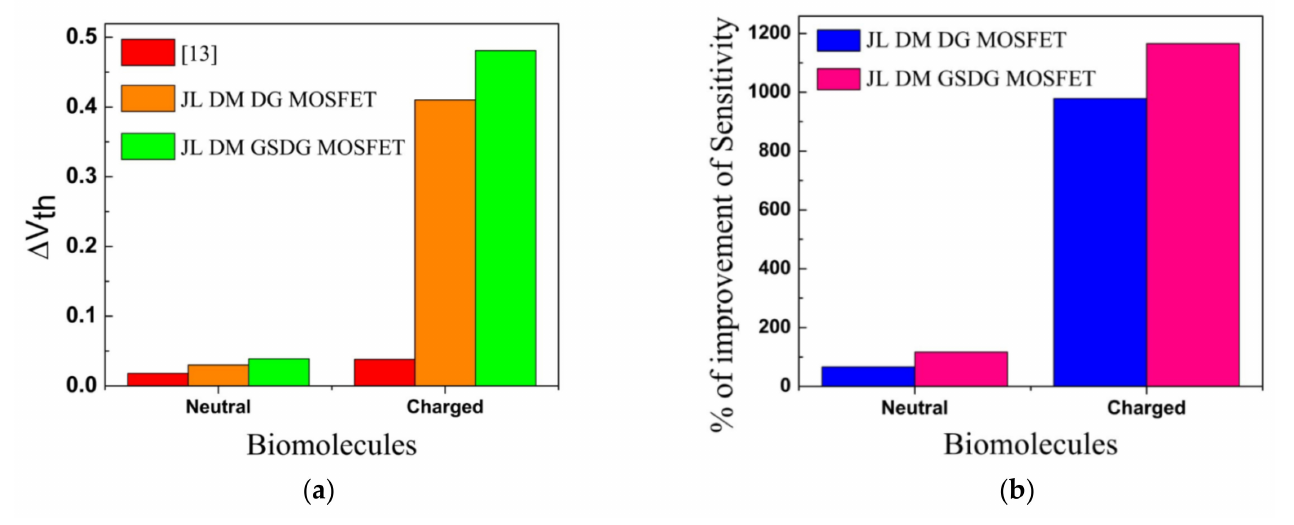
Figure 14. ( a ) Threshold voltage sensitivity of JL-DM-DG-MOSFET, JL-DM-GSDG-MOSFET, and